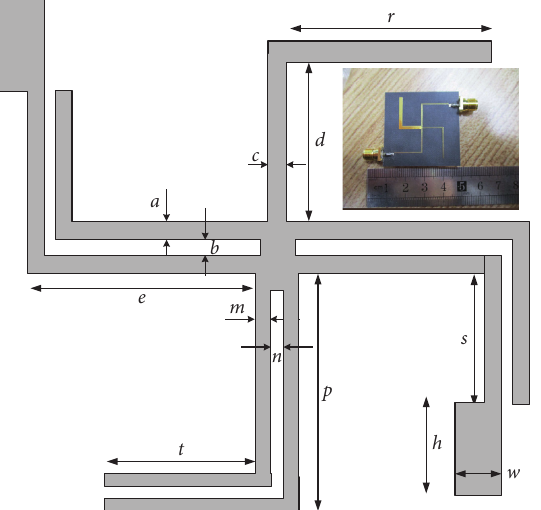
Figure 5: Physical layout for the proposed BPF and photograph of the proposed BPF (dimensions in mm).